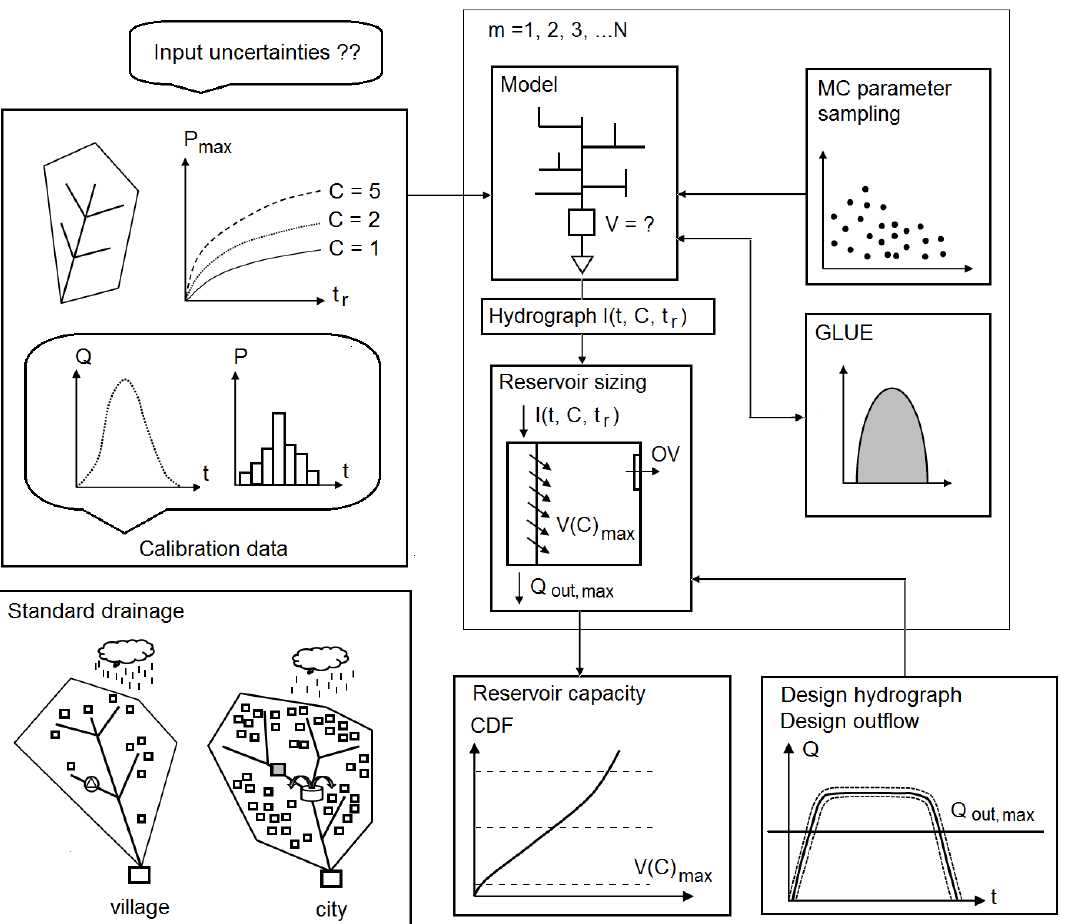
Figure 2. Calculation diagram of the method of dimensioning the retention capacity (where I ( t , C , t r ) —reservoir inflow hydrograph for given rain duration time ( t r ) and occurrence probability C , m = 1, 2, 3, . . . , N—subsequent Monte Carlo simulations with varying parameters [ α , d imp , d perv , n imp , n perv , n n , γ , β ], for which reservoir inflow hydrograph is compute, Q out , max —maximal allowed outflow form the reservoir, 𝑉(𝐶) 𝑚𝑎𝑥 — maximal reservoir retention capacity for given values of C and Q out , max .)